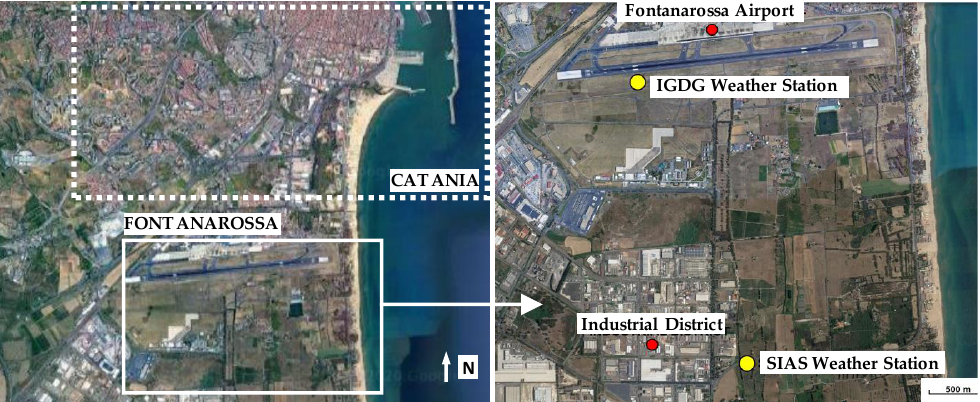
Figure 3. Position of the weather stations in relation to the city of Catania site.